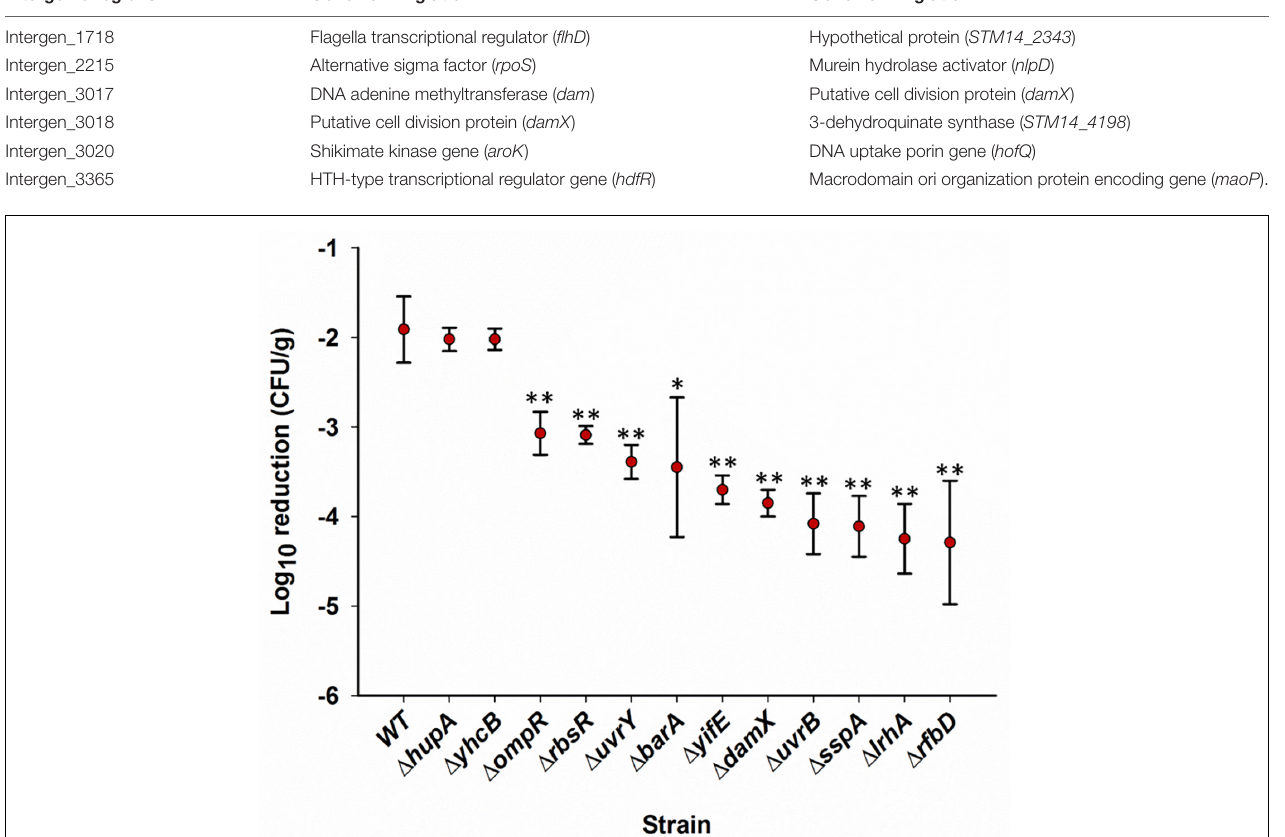
FIGURE 4 | Survival of individual single-gene deletion mutants on in-shell pistachios. Pistachios were inoculated with single strains, dried and stored. Populations of Salmonella were enumerated as log 10 CFU/g, as described in “Materials and Methods”, immediately after inoculation, after drying, and periodically during storage. The difference between the population immediately after inoculation and at 110 days of storage is plotted for each mutant. Data represent averages from two independent trials with duplicate samples processed per trial. Error bars indicate standard deviation ( n = 4). ∗ P < 0.05, ∗∗ P < 0.005, based on two tailed Student’s t -test. Supplementary Table 2 contains data for all time